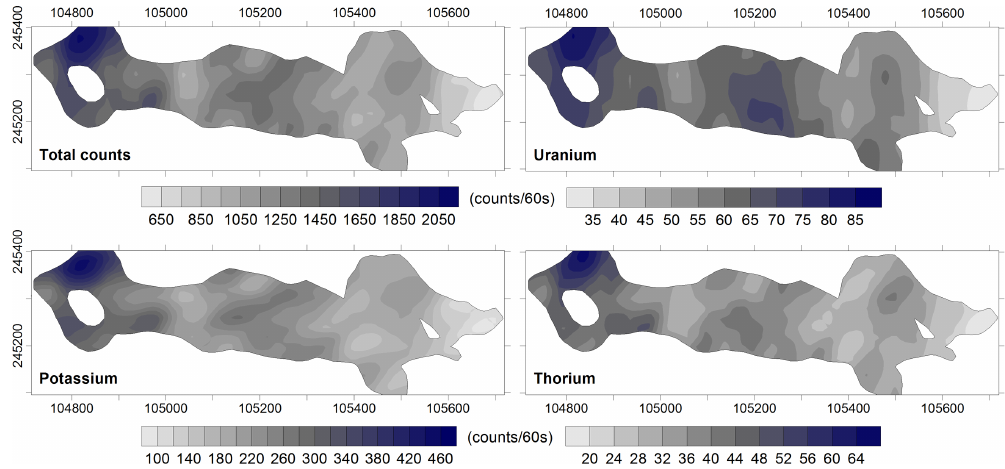
Fig. 4. Maps of interpolated gamma radiation (in counts per 60s) using individual data of Total Count (top left panel), potassium or K (bottom left panel) uranium or U (top right panel), and thorium or Th (bottom right panel). Note the different scales of data ranges. Coordinates on x- and y-axis are in metric BMN M28 Austrian coordinate